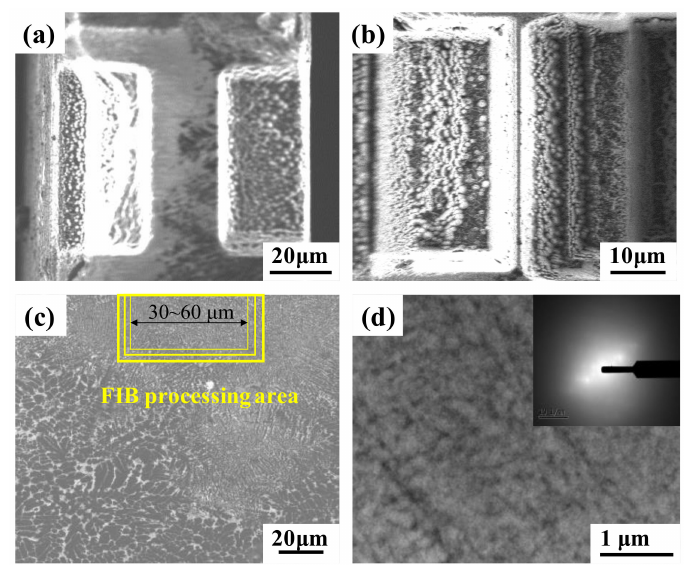
Figure 6. ( a , b ) TEM specimen by FIB technique of Mg-RE sheet with TRC; ( c ) SEM and FIB processing area on the Mg-RE sheet surface; ( d ) TEM image and high-resolution